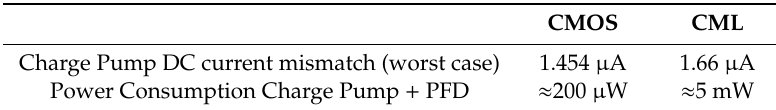
Figure 14. Comparison between the two CP/PFD (Phase Frequency Detector) architectures in terms of phase noise: Current Mode Logic (CML) architecture’s results in red, CMOS architecture’s results in black. Table 1. Comparison between the two CP/PFD architectures in terms of CP’s current matching and CP+PFD’s power consumption.